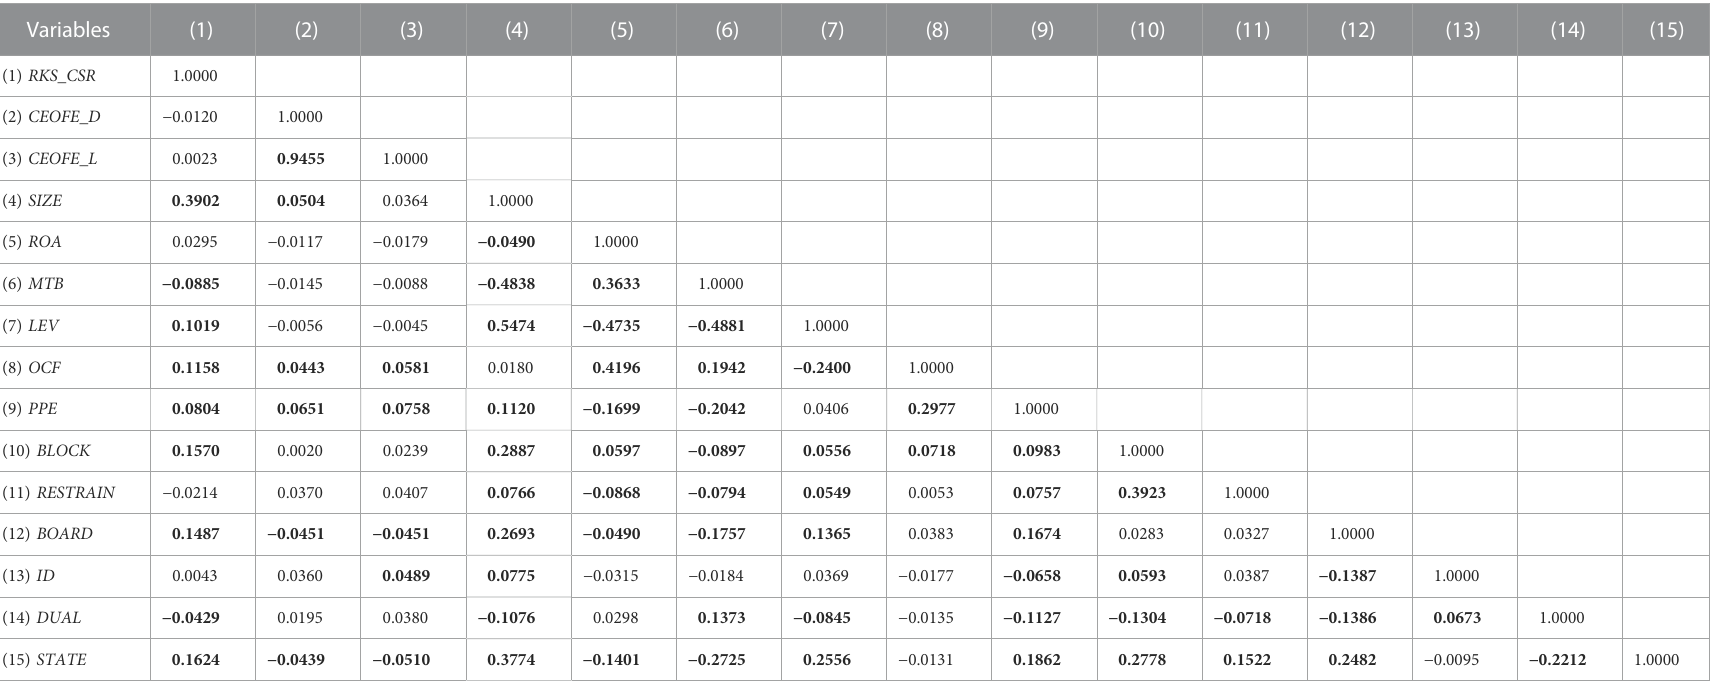
TABLE 4 Correlation